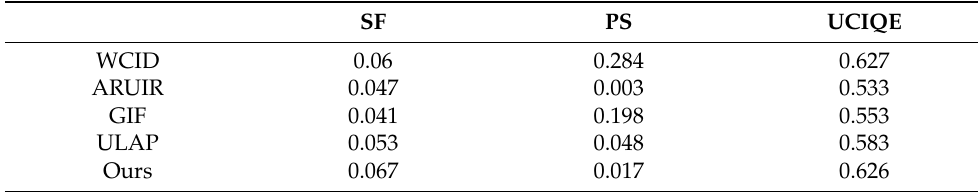
Table 3. Quantitative analysis of Figure 7.